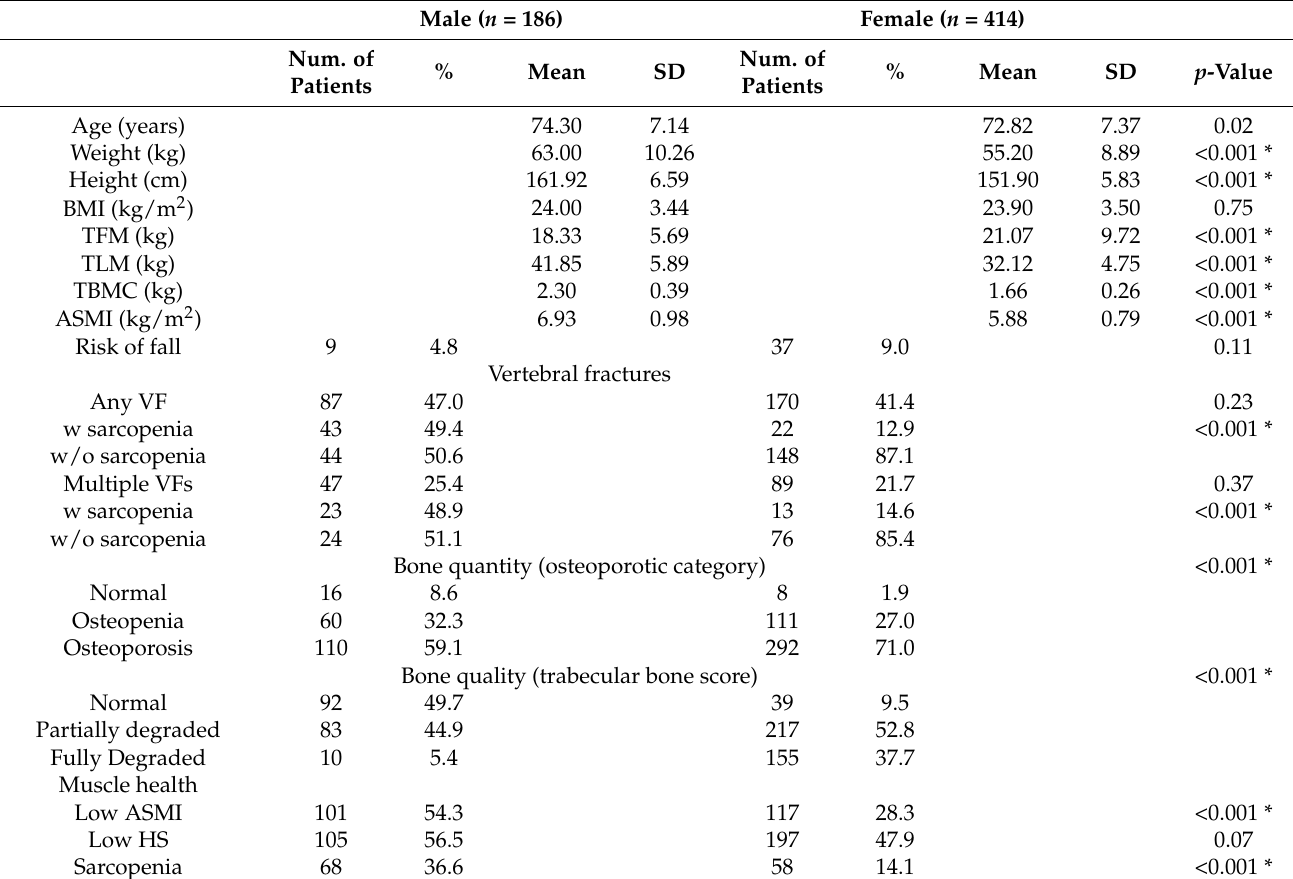
Table 1. Demographic data of the 600